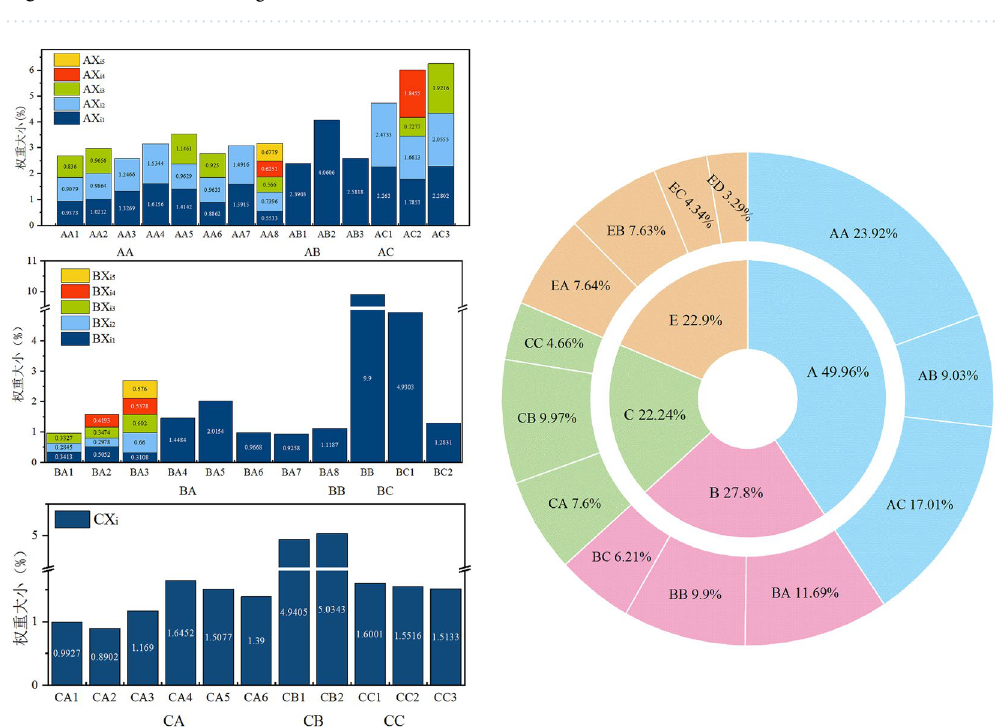
Figure 6. Calculation of weights for each level of the